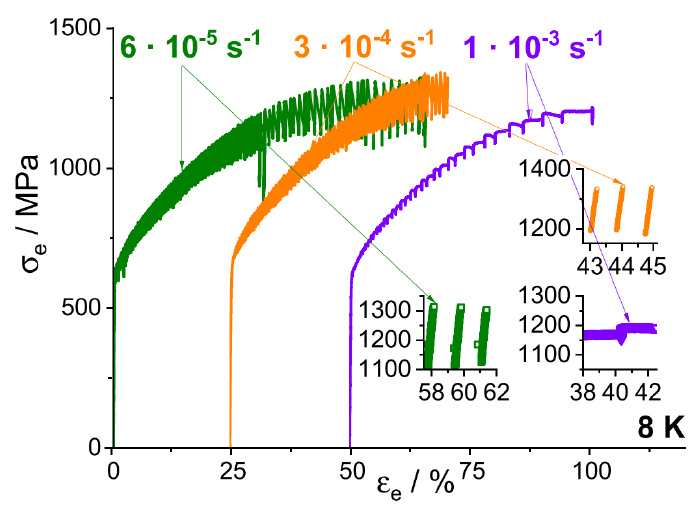
Figure 41 features the stress vs. strain data for the samples that were tested at 8 K and strain rates ranging from 6 × 10 −5 to 1 × 10 −3 s −1 . As can be observed, the characteristics of the serrated flow were affected by the strain rate. For example, the time between stress-drops apparently decreased with an increase in the strain rate. The insets of the figure suggest that, for strain rates of 6 × 10 −5 and 3 × 10 −4 s −1 , the serrated flow consisted of Type-B serrations. On the other hand, the serrations were reminiscent of Type-D behavior at the highest strain rate.